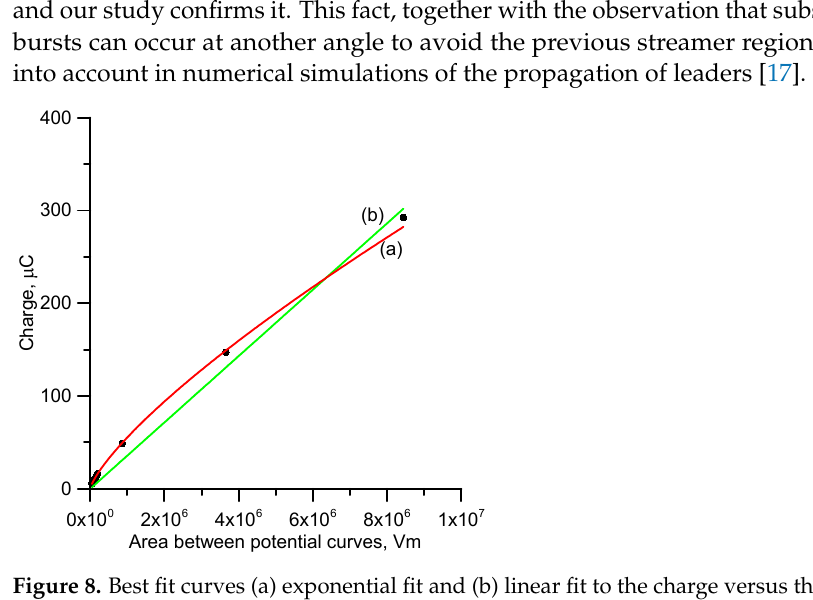
Figure 8. Best fit curves (a) exponential fit and (b) linear fit to the charge versus the area between the potential curves corresponding to a streamer branching length of 5 mm. The actual data points are also shown in the diagram.